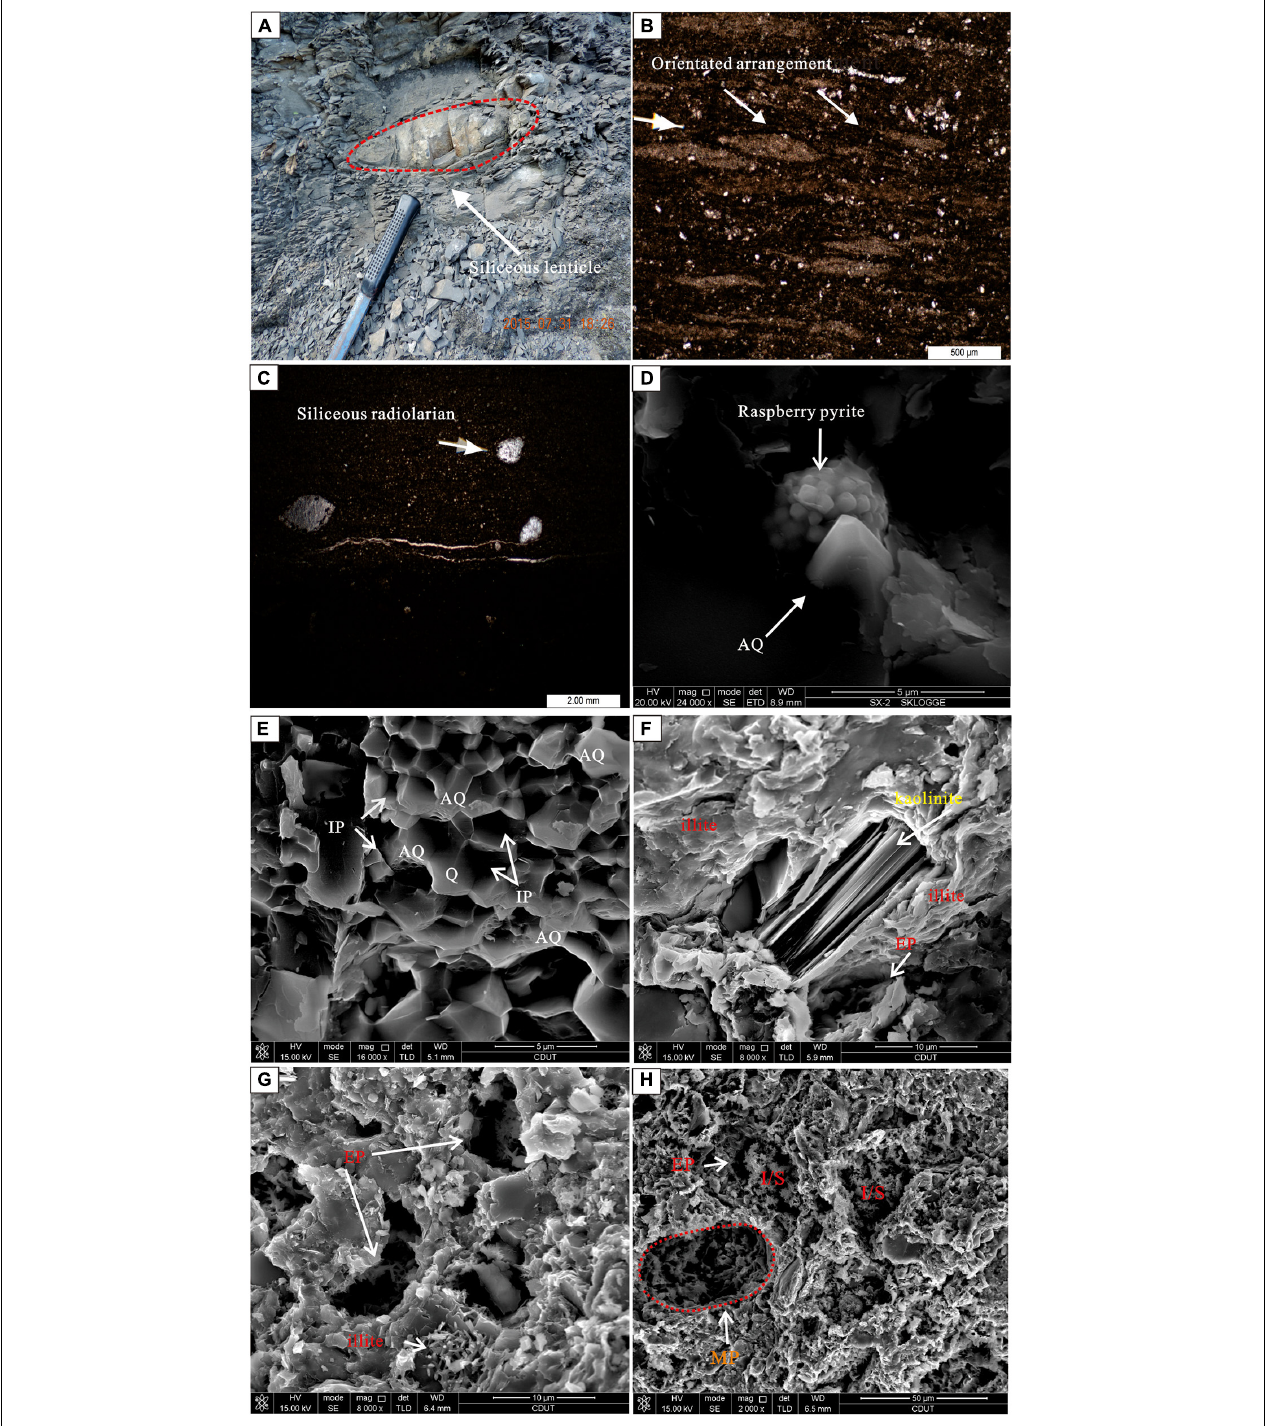
FIGURE 3 | Types and characteristics of pore spaces of the Longmaxi Formation shale in the Sichuan Basin [micrographs of thin sections and scanning electron microscope (SEM)]. (A) A photograph of the Longmaxi Formation Shale in the Xiushan field outcrop, showing the siliceous lenticle. (B) Micrographs of thin sections (MTS) showing the orientated arrangement of minerals, the Xiushan section, layer 3. (C) Micrographs of thin sections (MTS) showing the siliceous radiolarian, the Shizhu section, layer 4. (D) An SEM image showing strawberry pyrite and authigenic quartz (AQ), the Pengshui section, layer 2. (E) An SEM image showing inter-crystalline pores (IP) of authigenic quartz, the Shizhu section, layer 2. (F) An SEM image showing intergranular pores (EP) of clay minerals, the Xiushan section, layer 5. (G) An SEM image showing intergranular pores (EP) of illite, the Qijiang section, layer 6. (H) An SEM image showing intergranular pores (EP) and molded pores (MP) of illite–smectite mixed minerals, the Qijiang section, layer 5.